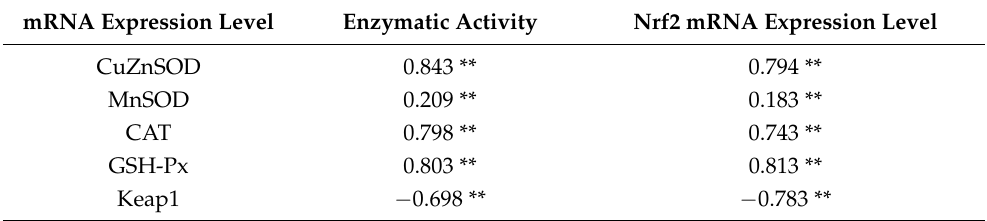
1 Abbreviations: CuZnSOD, copper-zinc superoxide dismutase; MnSOD, manganese superoxide dismutase; CAT, catalase; GSH-Px, glutathione peroxidase; Nrf2, nuclear factor erythroid 2-related factor 2. Two asterisk superscripts (**) represent significant at 0.01 level